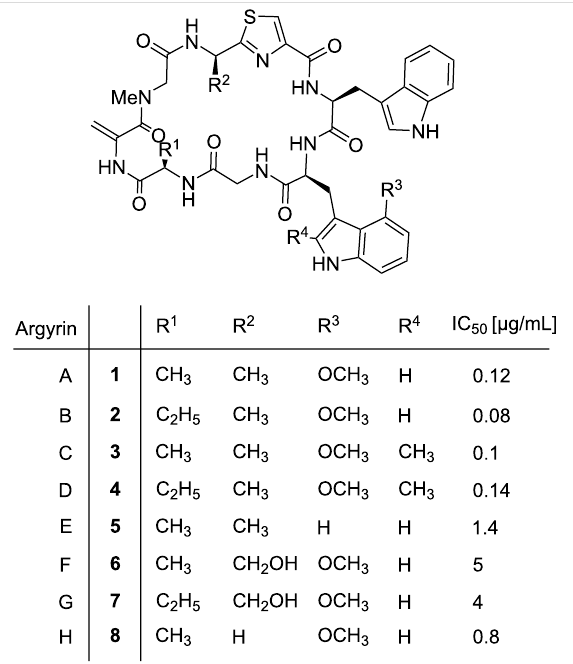
Figure 1: Chemical structures of naturally occurring argyrins with po- tent antipseudomonal activity.